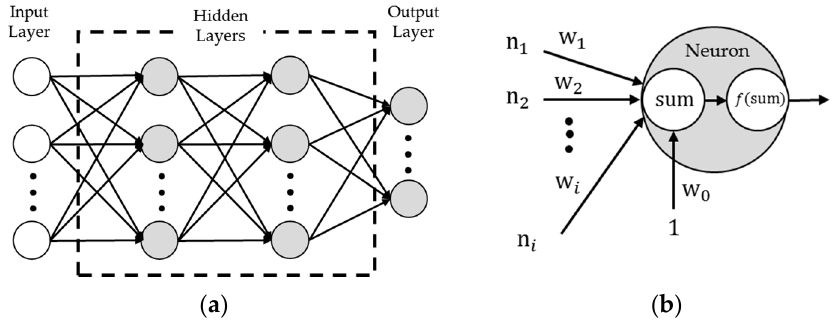
Figure 1. Graphic description of an Artificial Neural Network (ANN) ( a ) topology of multilayer perceptron (forward propagation); ( b ) internal process for each neuron.